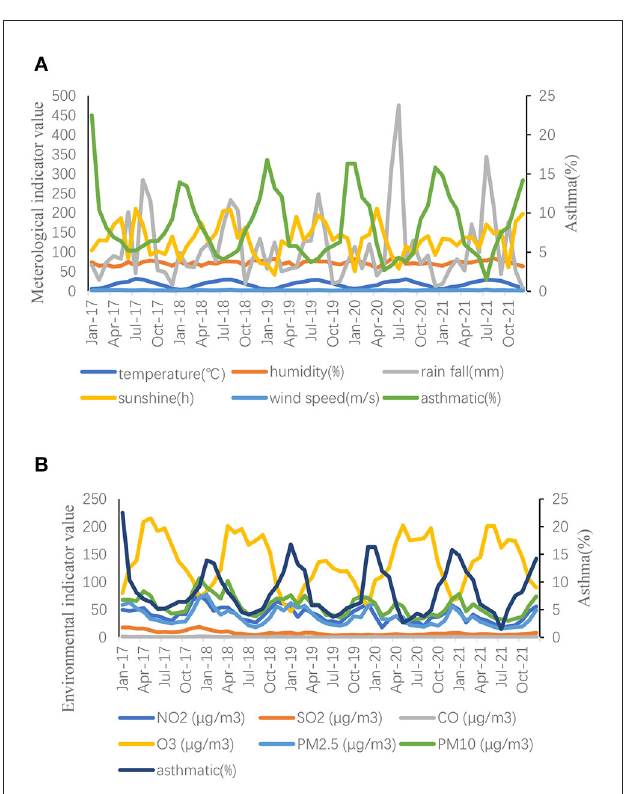
FIGURE2 (A, B) Data description of meteorological and environmental variables.